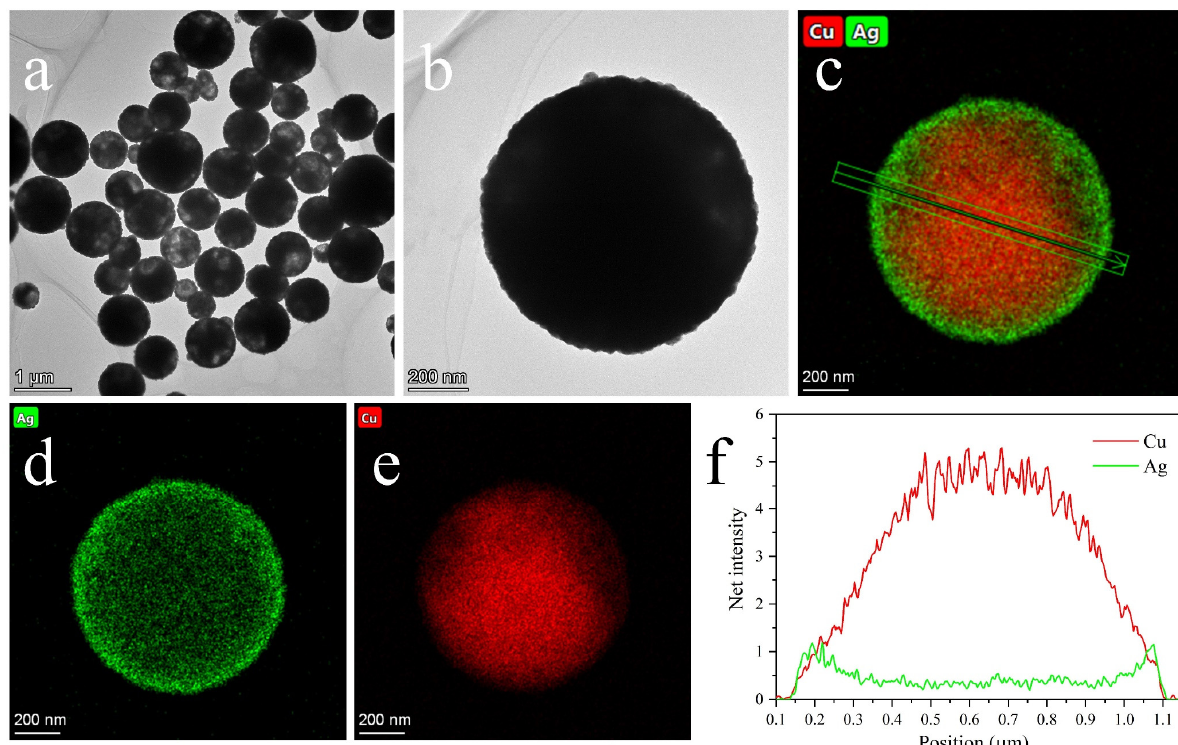
Figure 4. SEM images of ( a , c ) the as-synthesized Cu NMPs and ( b , d ) the as-synthesized Cu@Ag NMPs. The inserted figures show the particle size distribution.